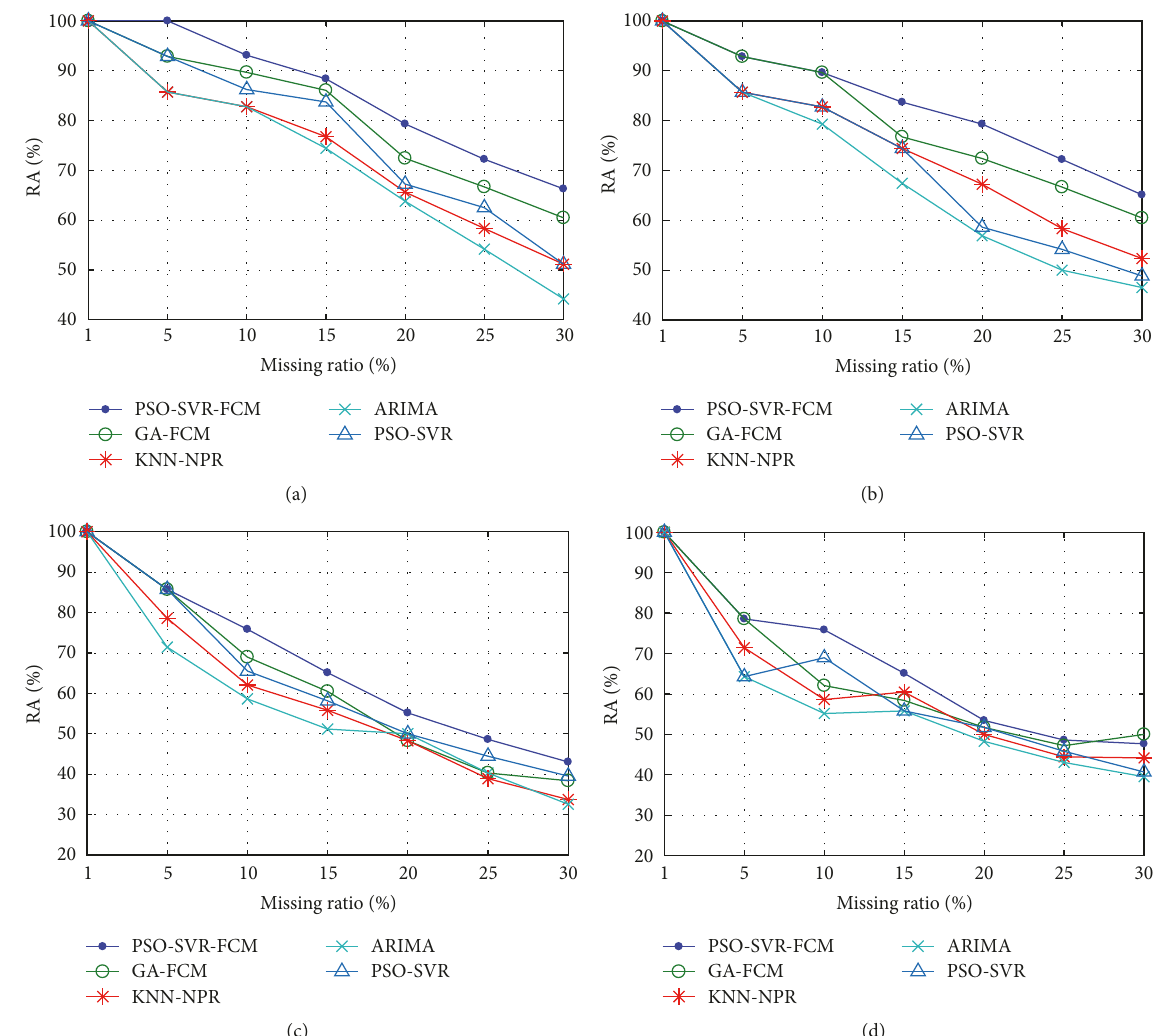
Figure 17: RA curve of each method for comparison in mixed MCR/MR pattern, using the traffic data collected from the detectors (a) NBXX13 (2) , (b) NBXX11 (4) , (c) DC00004964(E2), and (d) DC00004963(W2).